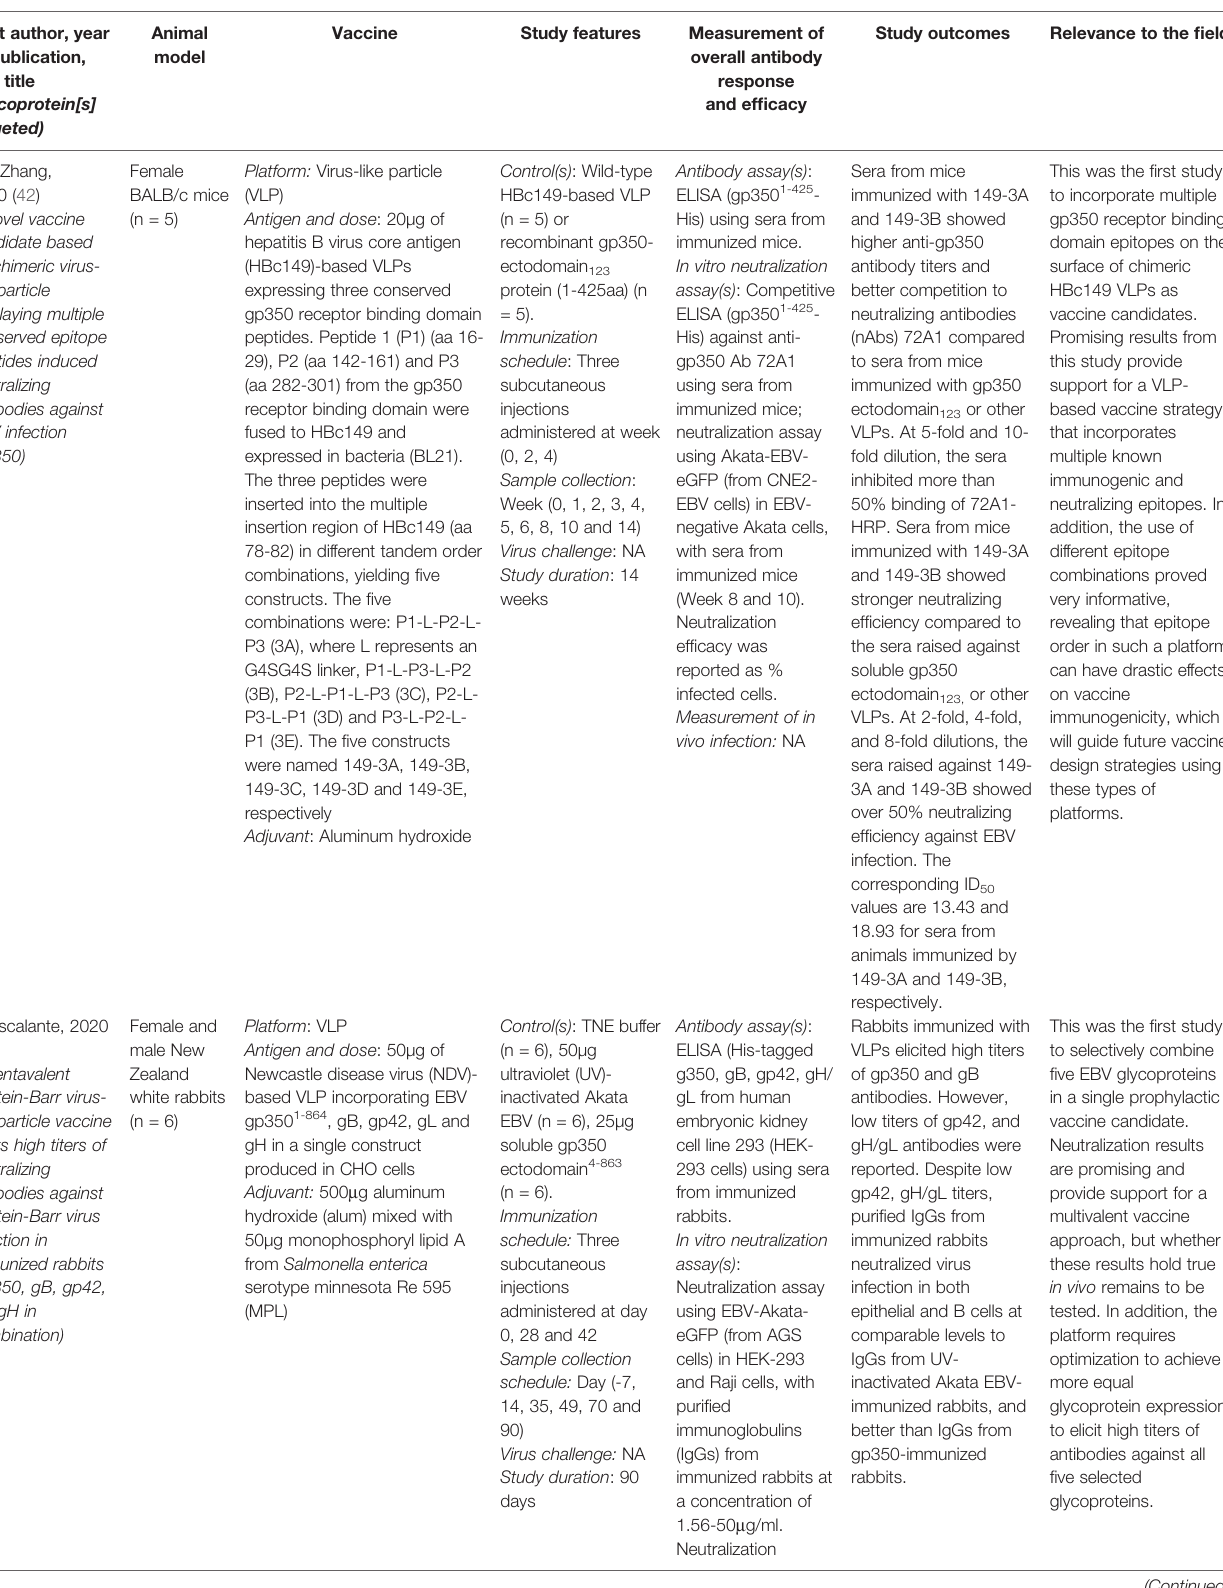
TABLE 3 | Characteristics of the pre-clinical studies included in the systematic